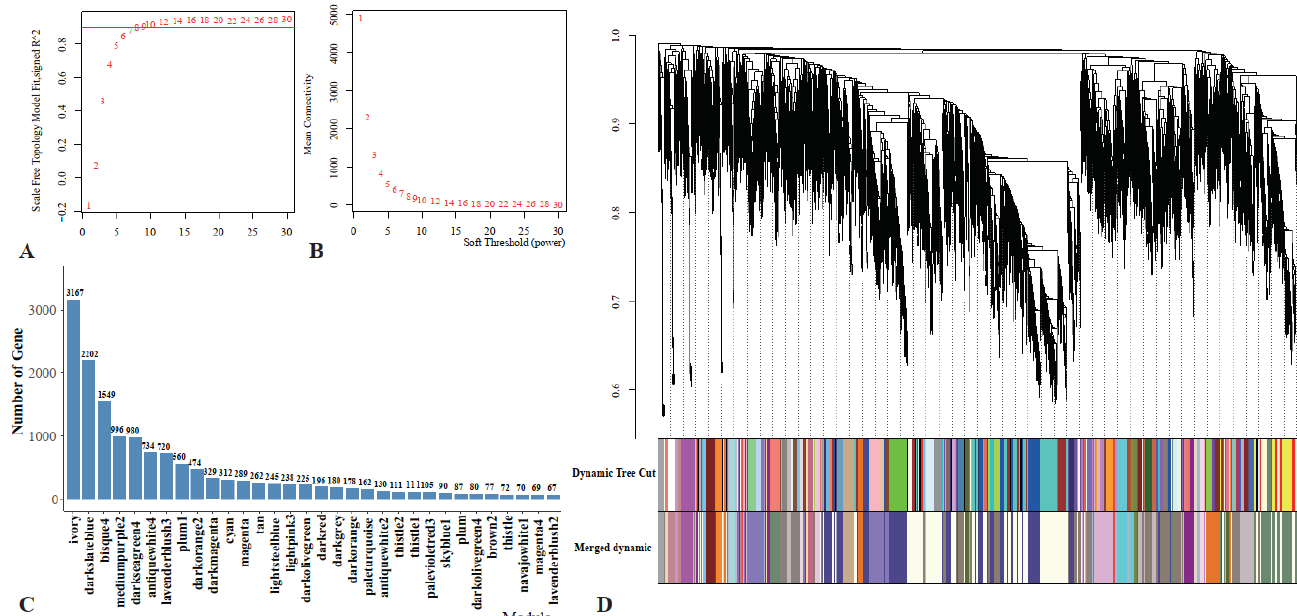
Figure 6. Co-expression network analysis diagram. ( A ) The scale-free fit index versus soft- thresholding power; ( B ) changes in average gene connectivity at different powers; ( C ) the number of genes in each module; and ( D ) clustering dendrograms of genes and different colors represent different modules.